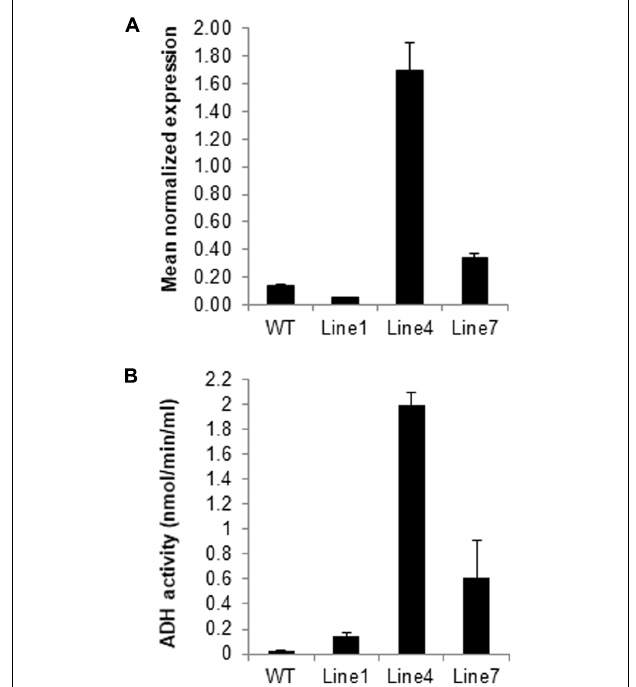
FIGURE 1 | Identification of sysr1 -transgenic plants. (A) Results of the qRT-PCR analyses of sysr1 expression in three transgenic lines (Lines 1, 4, and 7) used for salt-tolerance assays. The sysr1 transcription level was expressed as relative mRNA abundance (2 − (cid:49)(cid:49) C t ). Expression data were normalized against Nicotiana benthamiana EF1 α transcript levels. For each sample, three biological replicates were analyzed with corresponding technical replicates. (B) Leaf ADH activity was compared among control and transgenic N. benthamiana plants. Control: WT plants. Lines 1, 4, and 7: homozygous transgenic lines (T 3